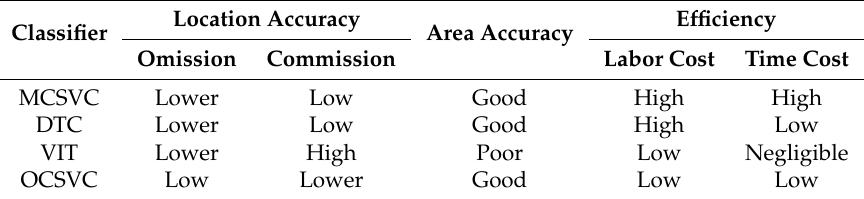
Comparison of the four classification methods by location accuracy, area accuracy, and